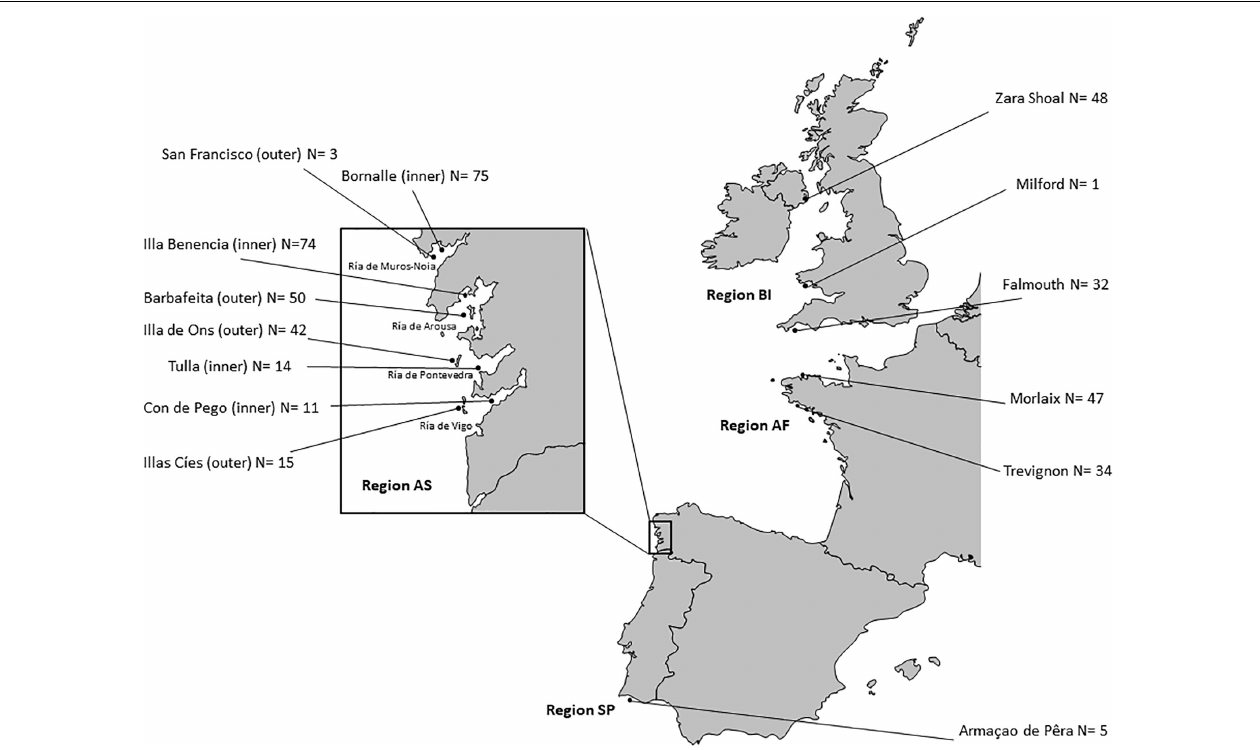
FIGURE 2 | Studied maerl beds, where Phymatolithon calcareum samples were collected and successfully scored for eight microsatellite markers (N, number of